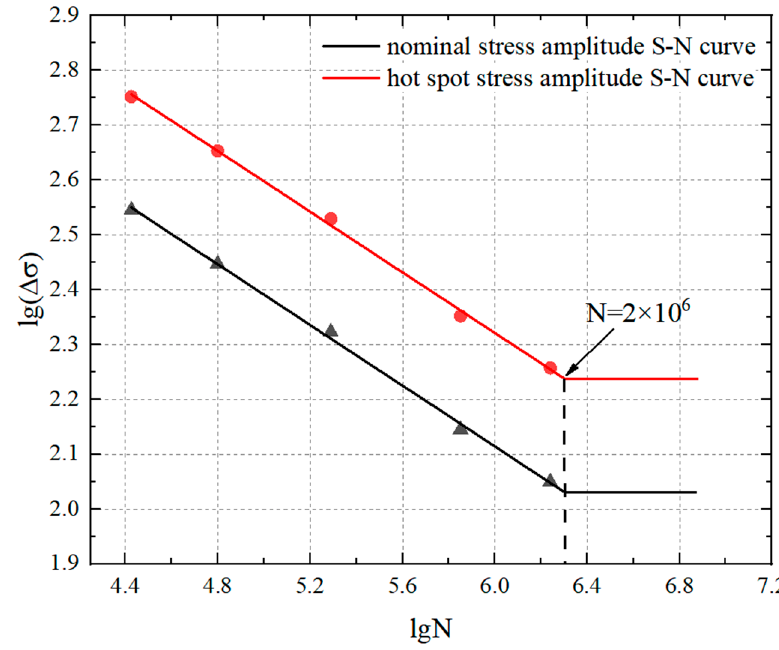
Figure 10. S ‐ N curves of M20 torque ‐ shear HSBs. Figure 10. S-N curves of M20 torque-shear